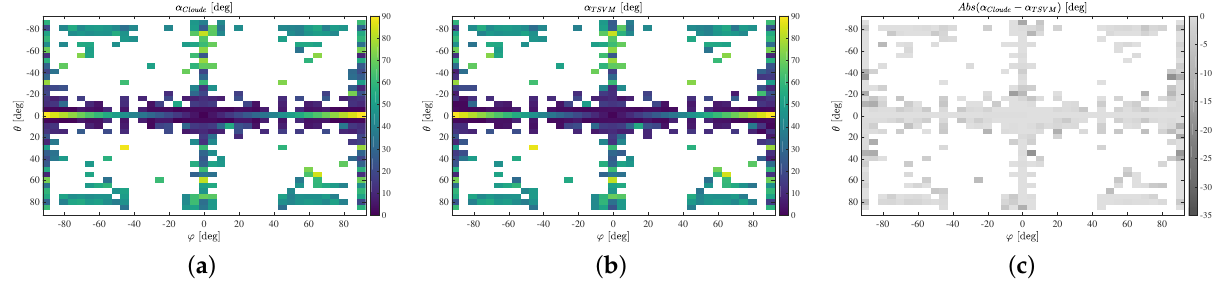
Figure 8. Square plate. ( a ) Estimation of α Cloude parameter for the plate’s response for a selection of observation directions. ( b ) Estimation of α TSVM parameter for the plate’s response for a selection of observation directions. ( c ) Absolute difference between results from ( a , b